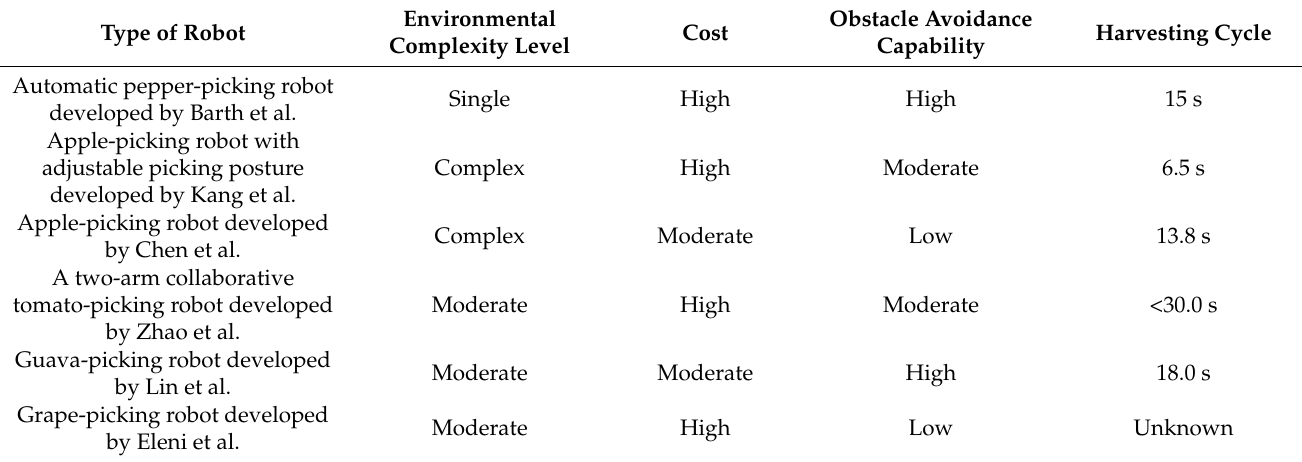
Table 1. Comparison table of available fruit and vegetable picking